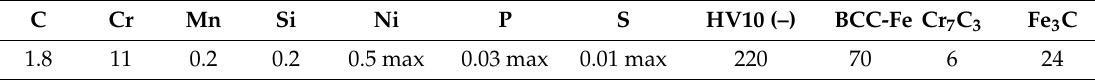
Table 1. Chemical composition (wt. %) and fractions of individual phases (vol. %) of X210Cr12